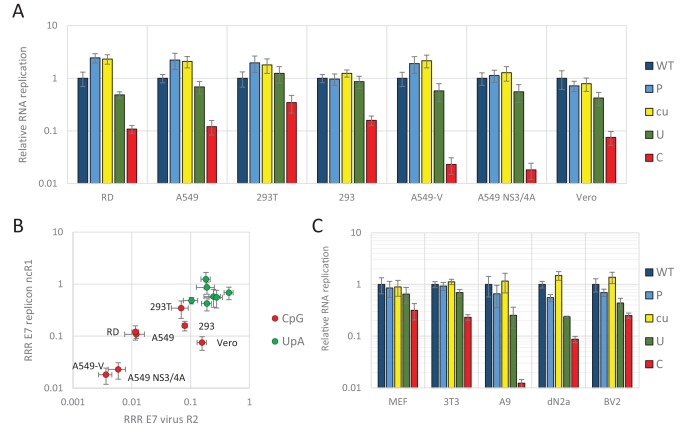
E7 replicon RNA replication is restricted by increased UpA and CpG dinucleotides in a non-coding region.(A) Relative RNA replication (RRR) of the E7 replicon with wild type (WT), permutated (P), CpG and UpA low (cu), UpA high (U) and CpG high (C) composition in an extended 3’-ncR1 as measured by firefly luciferase expression at six hpt in primate cells. (B) Comparison between E7 virus and replicon replication rates. Each data appoint refers to the RRR of E7 replicon RNA replication with ncR1 of the indicated composition (Y-axis) against the RRR of E7 virus with coding R2 in the same cell line (Figure 1 and S1, X-axis). (C) RRR of the E7 replicon with various nucleotide compositions in the 3’-ncR1 as measured by firefly luciferase expression at six hpt in rodent cell types. Bars represent the average of three biological replicates relative to E7 replicon RNA replication with a ncR1 of WT composition. Error bars represent one standard error of the mean.